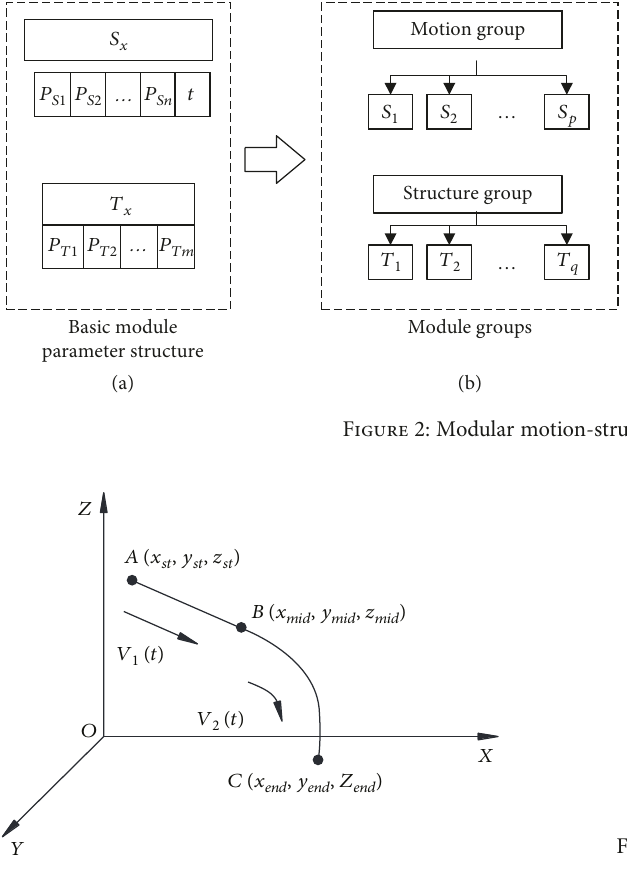
Figure 3: Motion module coordinate system.